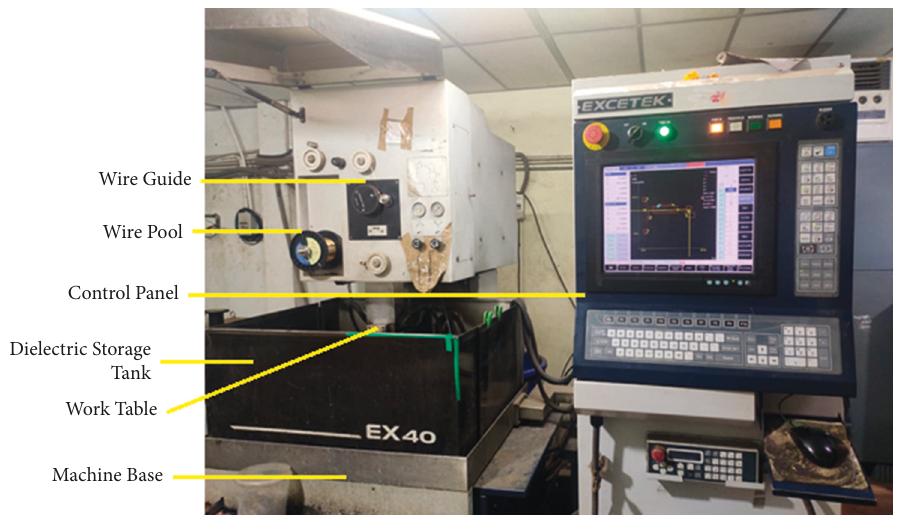
Figure 1: CNC excetek wirecut electric discharge machine.